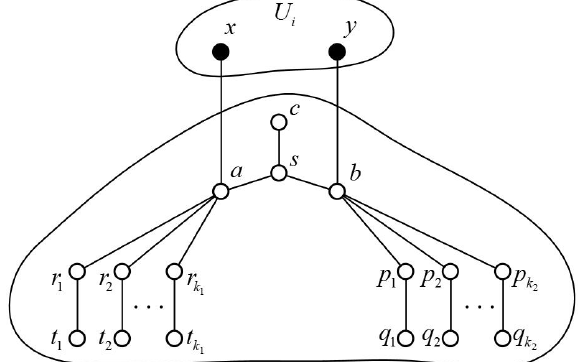
Figure 1. The operations O 3 , or O 4 , or O 5